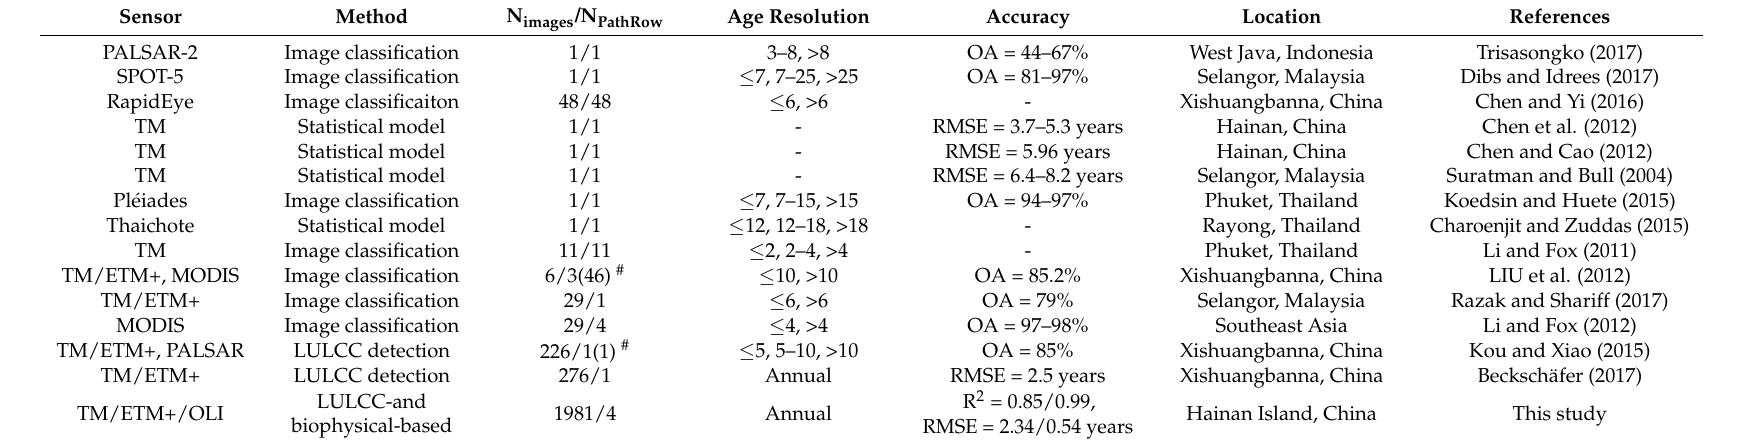
Table 2. Comparison of peer-reviewed studies for estimating establishment year (stand age) of rubber